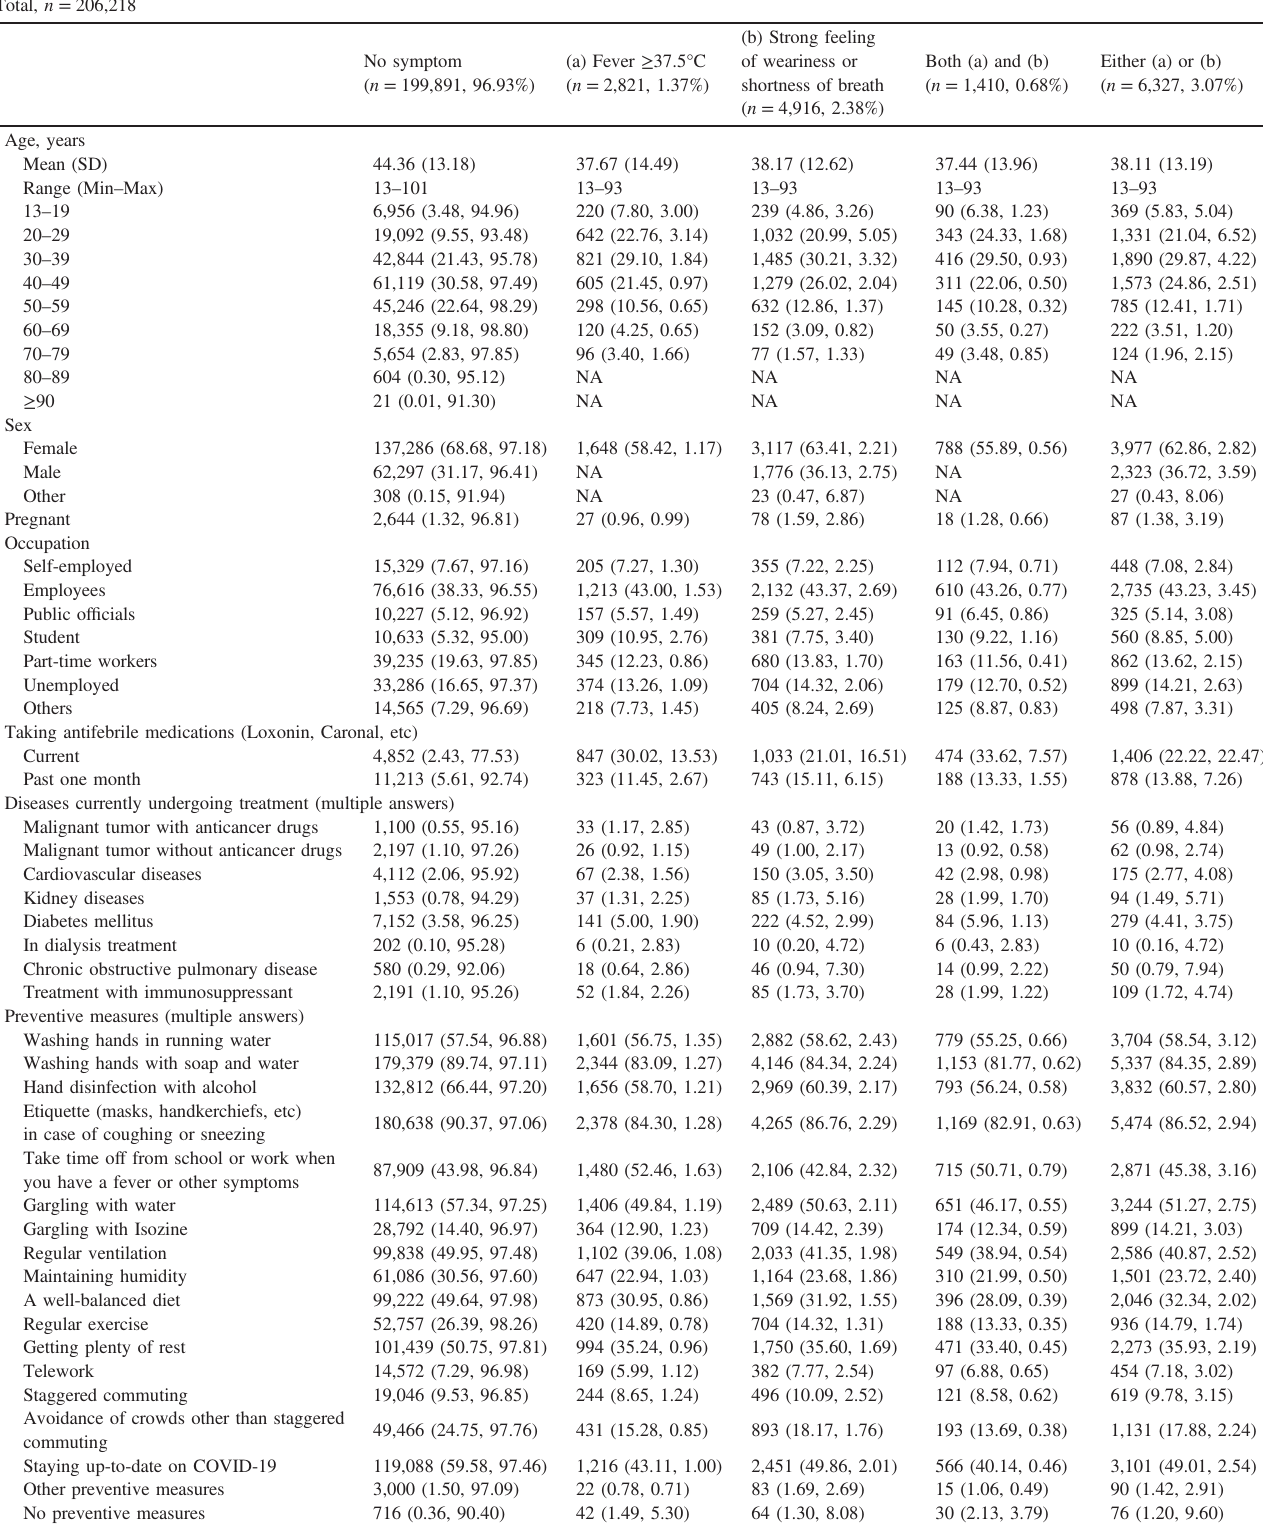
Table 1. Demographic characteristics of the participants by health states during the study period for the three prefectures combined, as